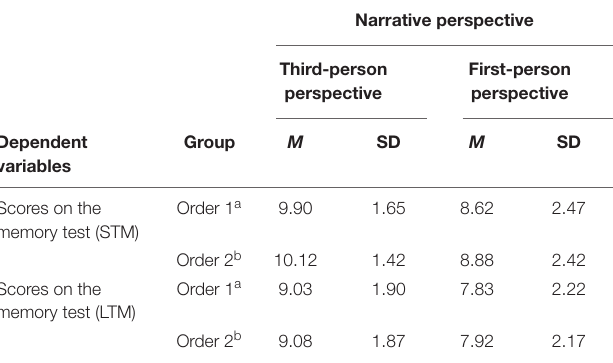
TABLE 2 | Mean and SD of the performance on the memory tests by group, narrative perspective and memory type (STM,